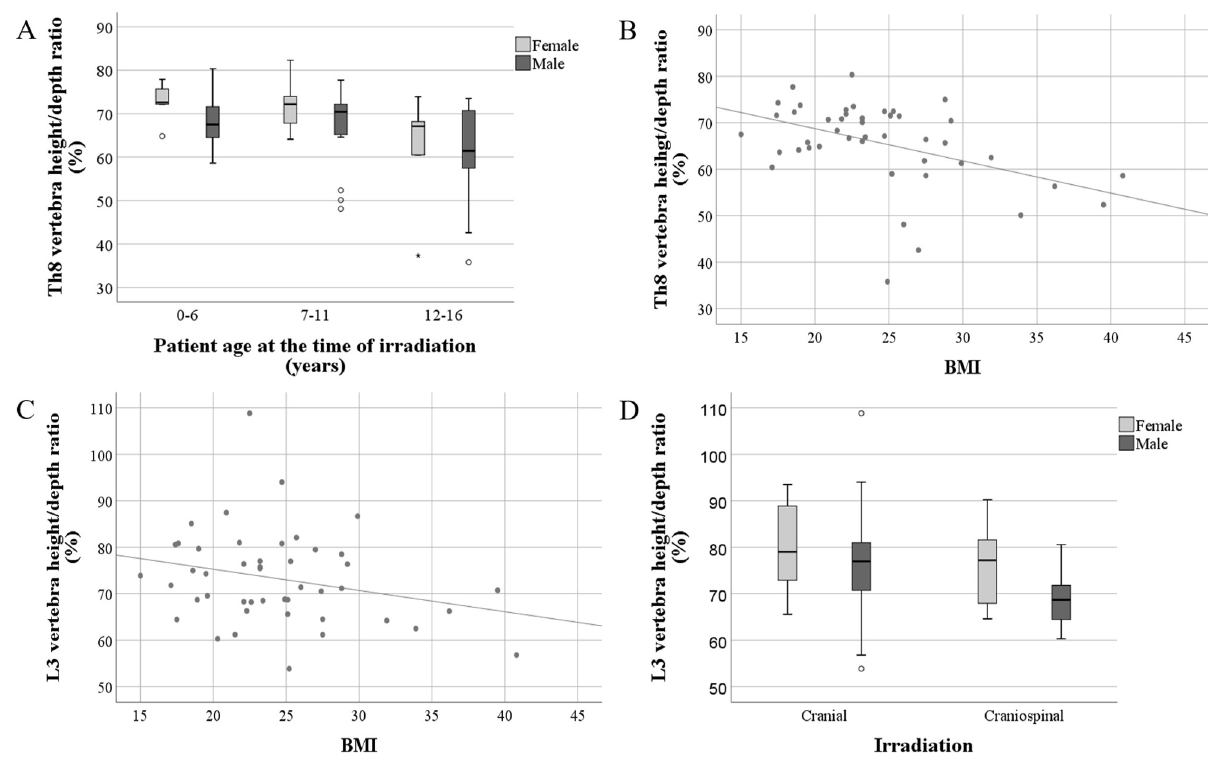
Fig 3. Association of the vertebral morphology to the BMI, mode of irradiation and treatment age. Association of the Th8 vertebra morphology with treatment age ( A ) and BMI ( B ). Association of the L3 vertebra morphology with BMI ( C ) and mode of irradiation ( D ).